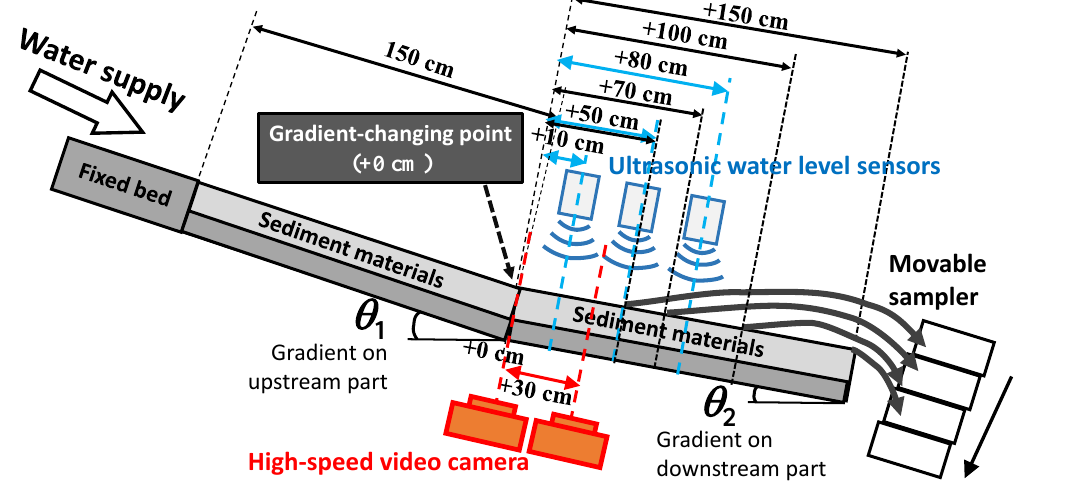
Figure 1. Experimental setup. Table 1. Experimental cases and